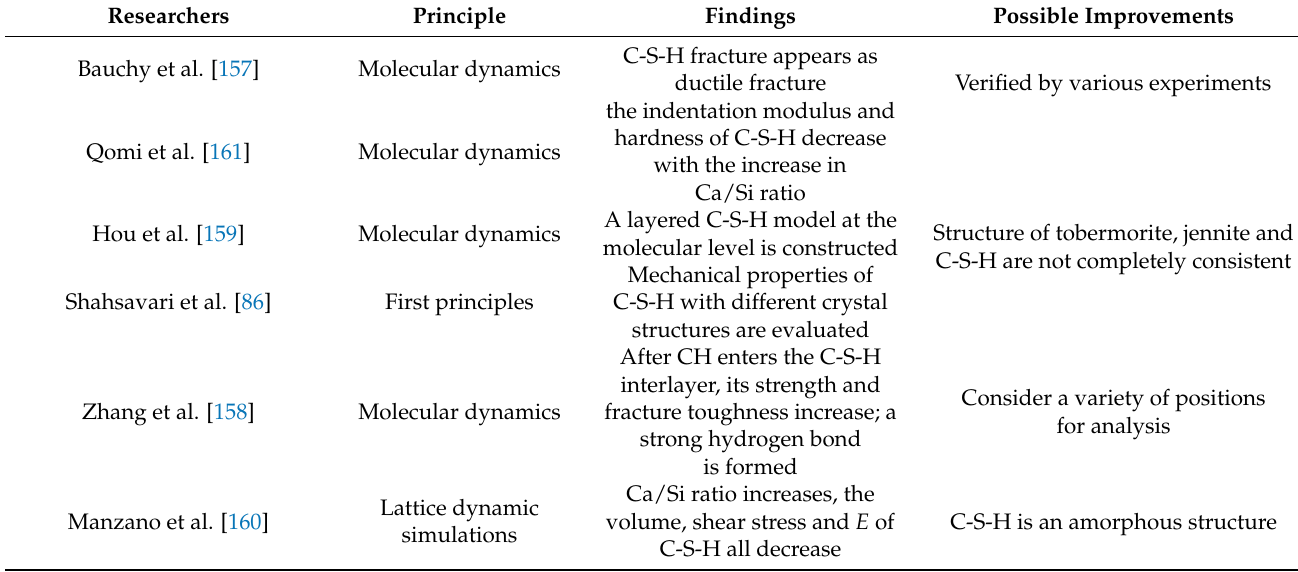
Table 6. Mechanical simulation of C-S-H.